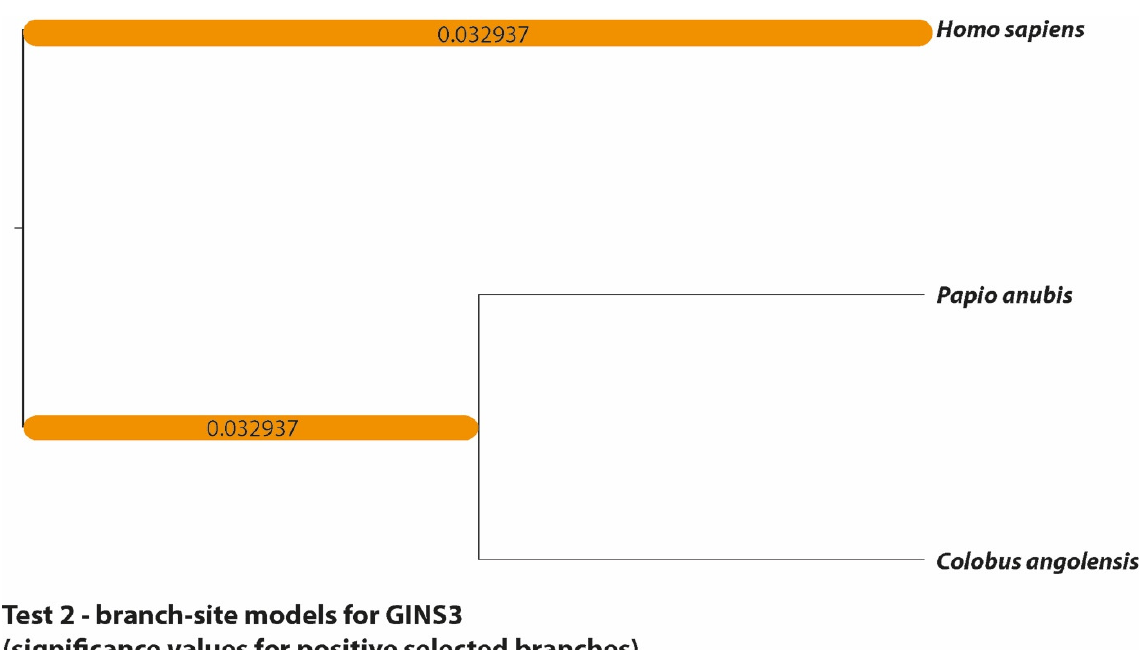
Figure 4. Phylogenetic tree of the GINS3 dataset. Branches significantly likely to be under positive selection according to the branch-site models are marked orange (corresponding to Figure 2) and labelled with the p -values inferred by their respective model comparisons. Table 3. Results of the selection analyses. The number of branches under positive selection detected by the branch-site model did not include branches with significant LRT results but without sites under positive selection. Overlaps between found sites were counted for all models with which they were found.